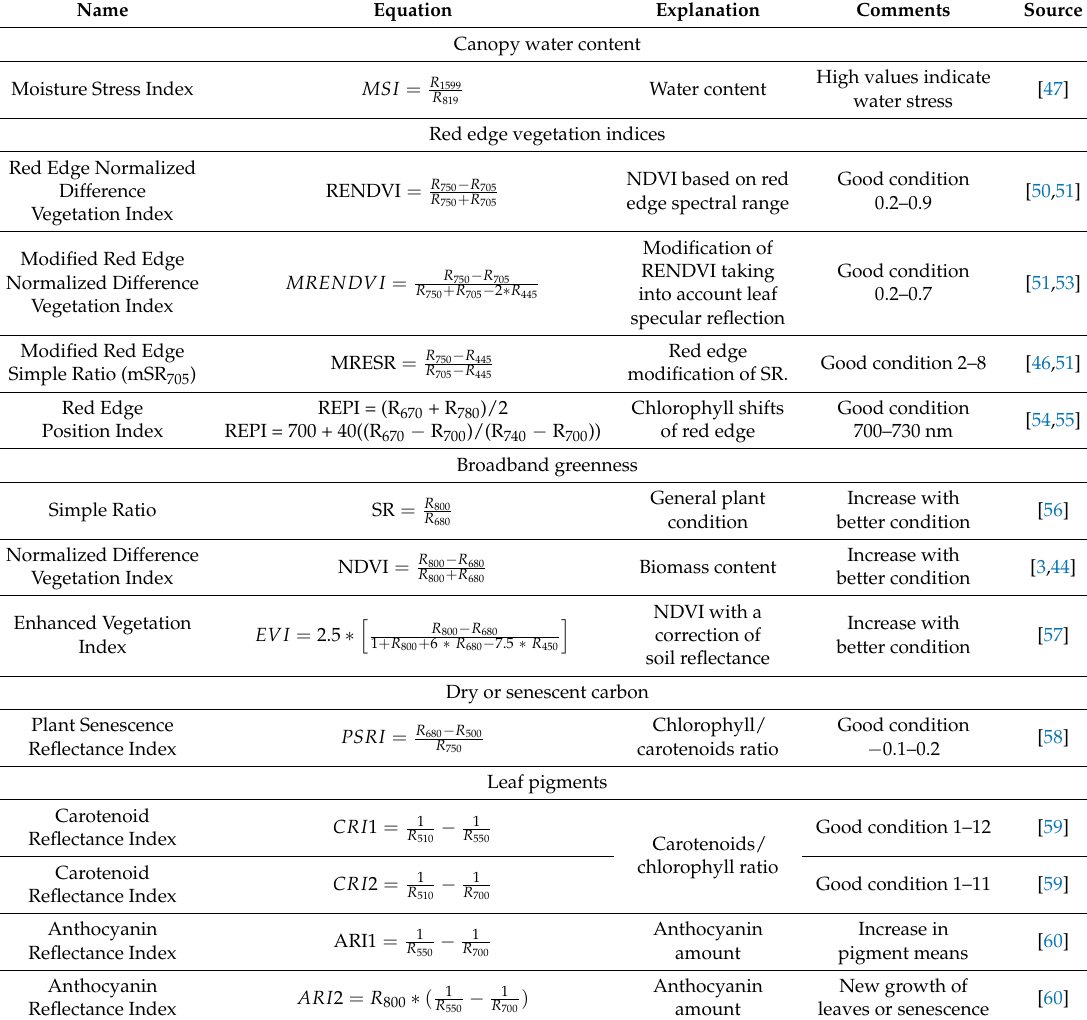
Table 2. Vegetation indices calculated from the sampled reflectance